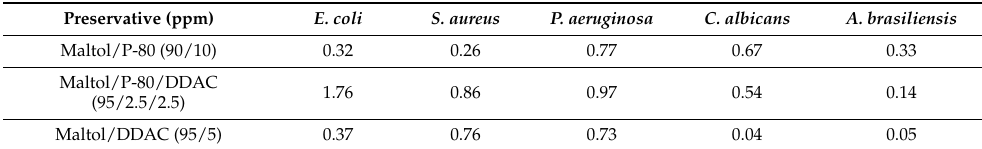
Table 8. FICI values for the three blends: Maltol/P-80 (90/10), Maltol/P-80/DDAC (95/2.5/2.5) and Maltol/DDAC (95/5) based on the MIC results presented in Table 1 and Figure 3. Preservative